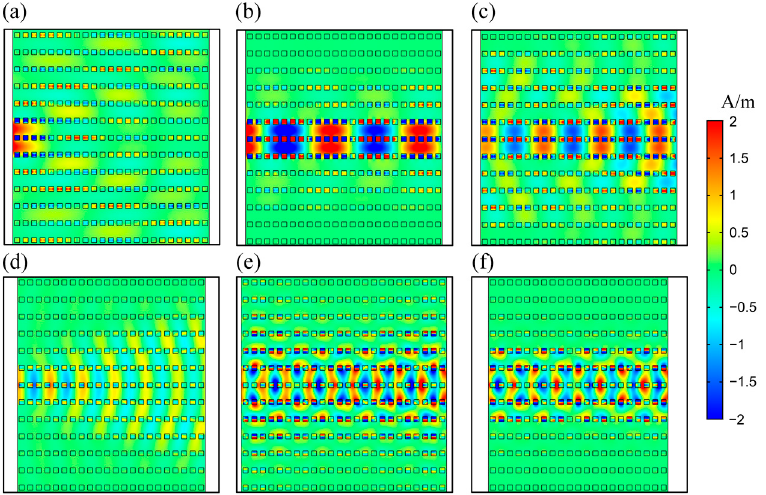
Figure 4. Magnetic field distributions of wave propagating in PHCs at various frequencies, with Gaussian-shape incident light located on the left. The operating frequencies of incident light are ( a ) 58.00 THz, ( b ) 59.52 THz, ( c ) 62.00 THz, ( d ) 100.00 THz, ( e ) 102.60 THz and ( f ) 102.90 THz.